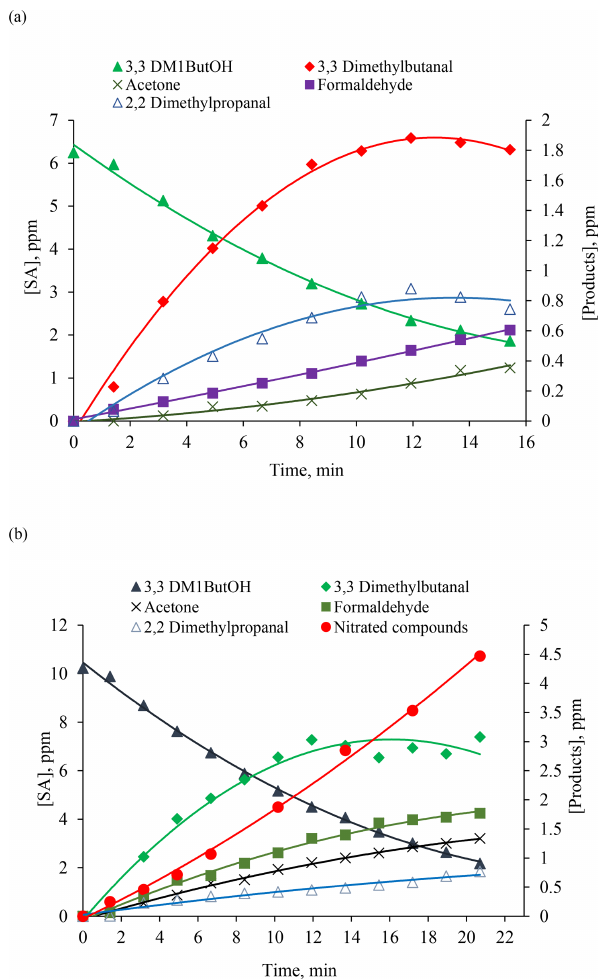
Figure 6. Concentration–time profiles of SA (3,3DM1ButOH) and reaction products formed in the reaction of 3,3DM1ButOH with Cl atoms in the absence (a) and in the presence of NO x (b)